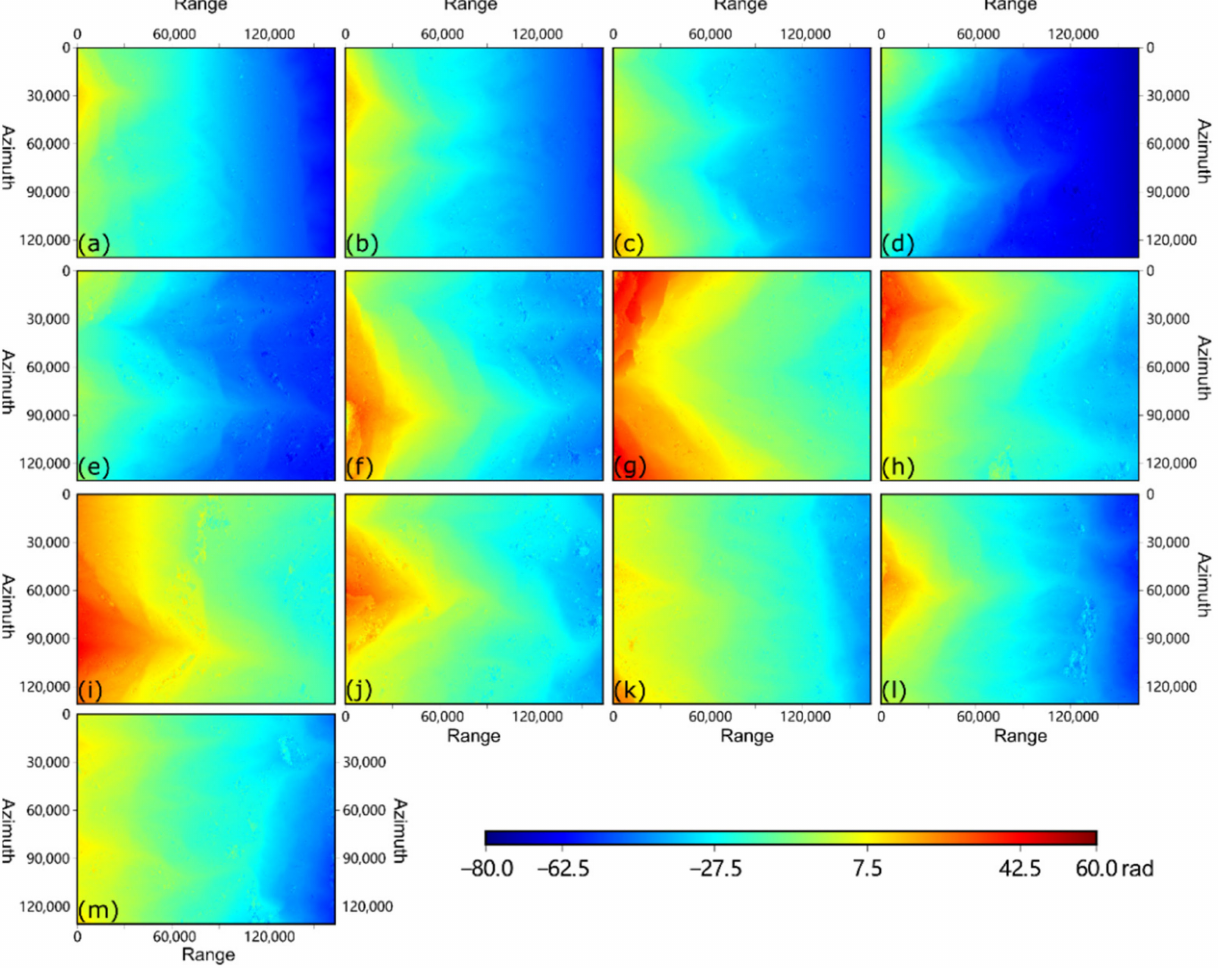
Figure 8. The 13 scenes of unwrapped phase data in the Qionglai experiment from the proposed PU method based on MBTs, ( a – m ) refer to unwrapped phase in scene a – m in Figure